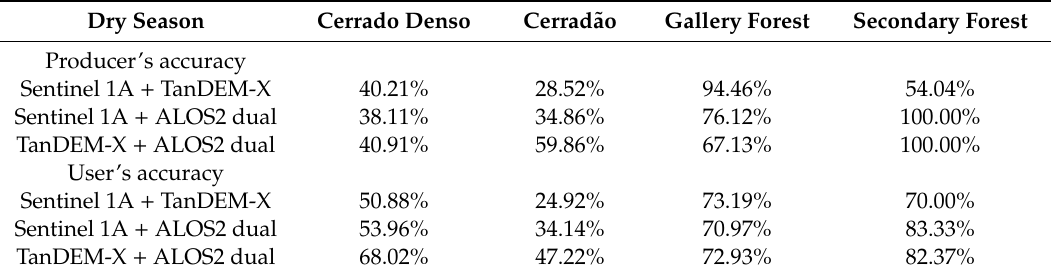
Table 6. Producer’s and user’s accuracy of classifications based only on combinations of SAR sensors for the four Cerrado types. Only data acquisitions during the dry season were